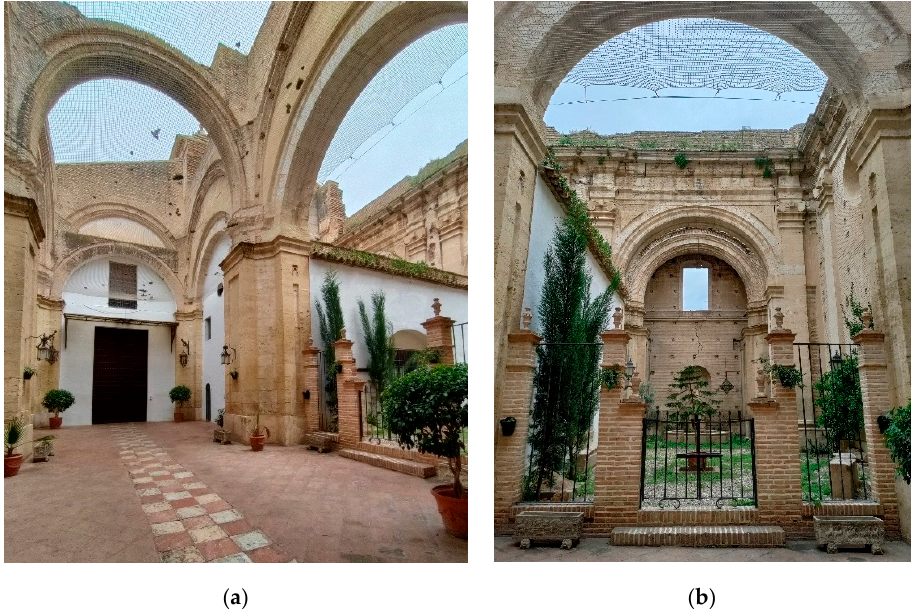
Figure 3. Atrium in the first two bays; ( a ) main entrance; ( b ) little central garden in the central bay.